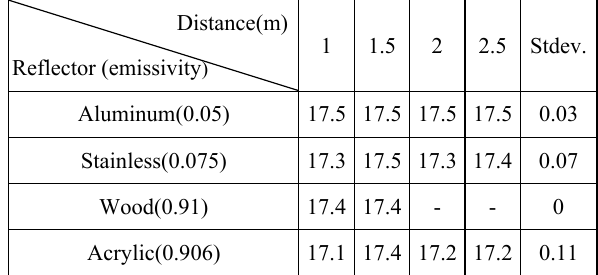
Table 1 Temperature ( ) ℃ of shadow on different distance between target and